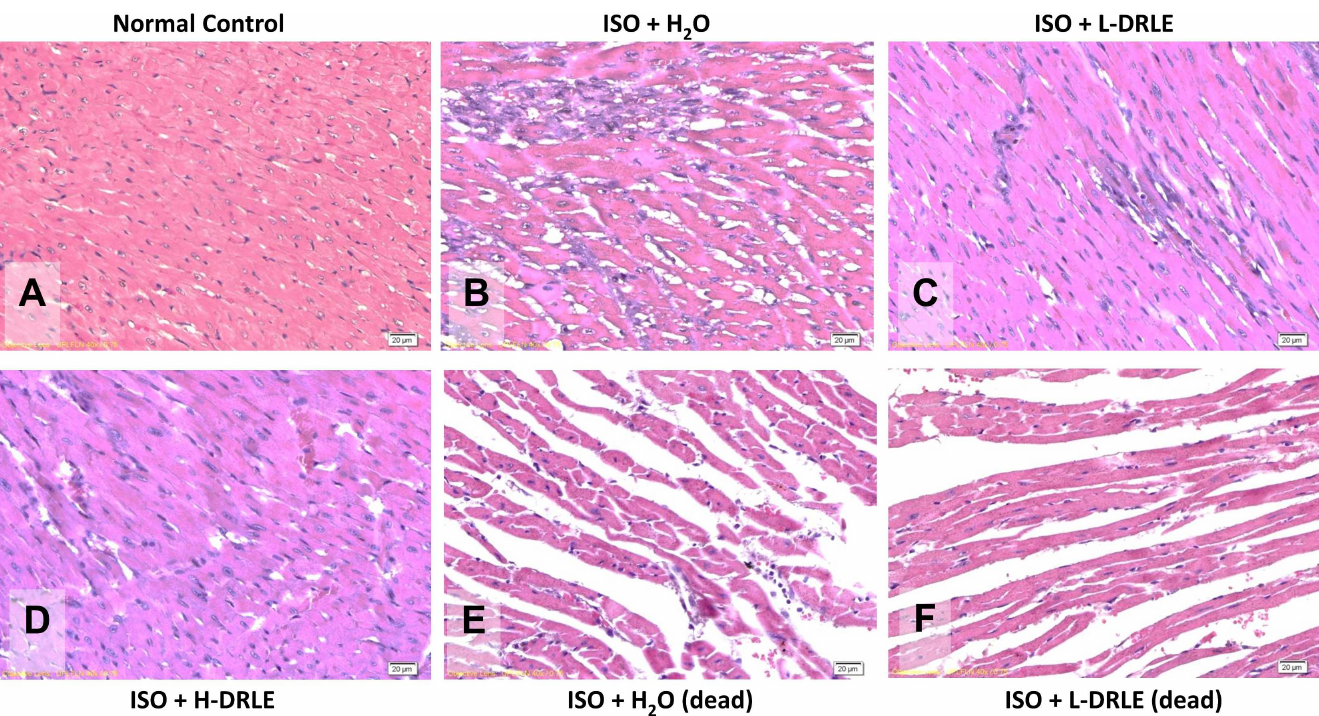
Fig 3. DRLE alleviated ISO-induced heart injury. Pathologicalexamination of heart tissues in normal and ISO-induced mice fed with or without DRLE (H&E, 400X). (A) Normal control; (B) 60 mg/kg/d of ISO; (C) 60 mg/kg/d of ISO + 100 mg/kg/d of DRLE (L-DRLE); (D) 60 mg/kg/d of ISO + 400 mg/kg/d DRLE (H-DRLE); (E) 60 mg/kg/d of ISO (mice dead before sacrifice); and (F) 60 mg/kg/d of ISO + 100 mg/kg/d of DRLE (mice dead before sacrifice).